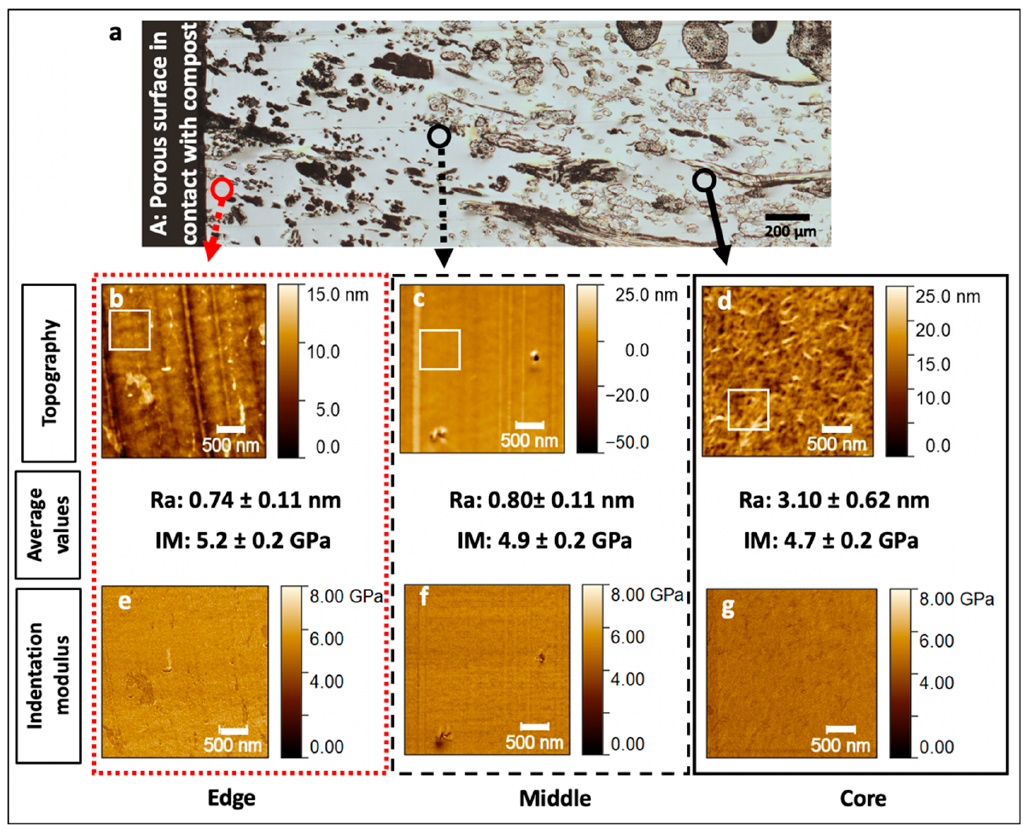
Figure 6. Maps of PLA topography and indentation modulus in the edge ( b , e ), middle ( c , f ) and core regions ( d , g ), respectively. Red and black circles on the investigated composite section ( a ) represent the areas examined through AFM. Average values of roughness (Ra) and indentation modulus (IM) are given. Average roughness was calculated through topography acquisition in the areas delimited by white squares (55 × 55 px) and average modulus was calculated in the whole image avoiding the defects when possible (around 65,500 force curves); at least three images were used to calculate the mean roughness and modulus in each region.